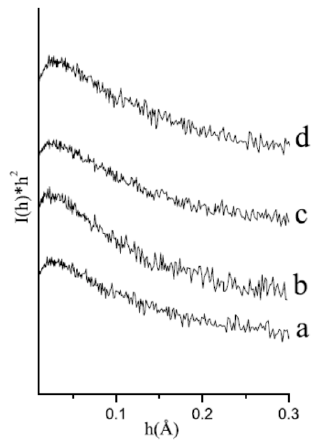
Figure 6. Kratky plots of samples ( a ) MC, ( b ) MC Ala-Phe, ( c ) MC Ala-Pro and ( d ) MC Pro-Phe.